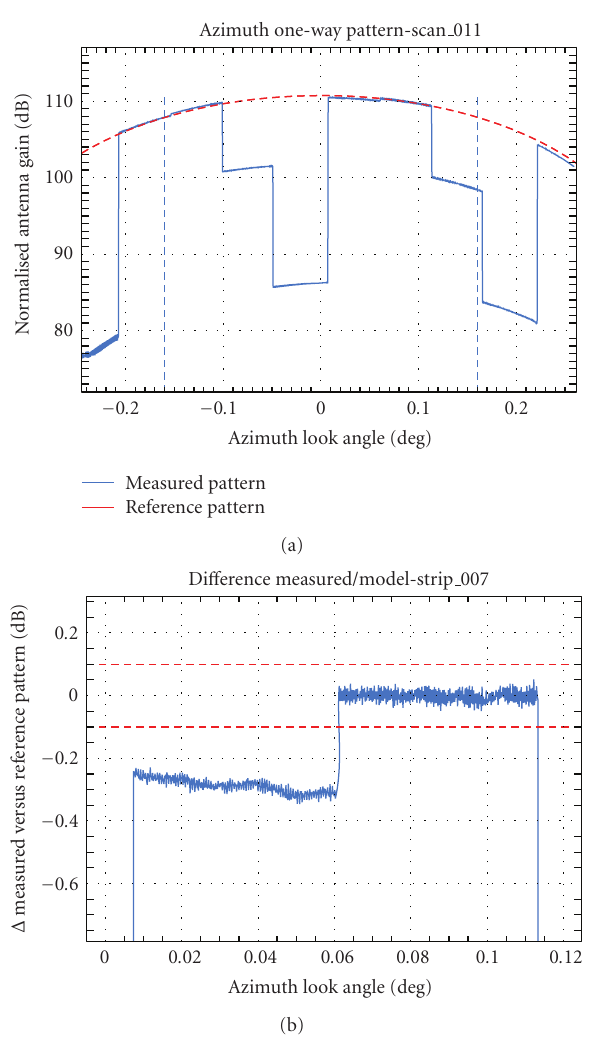
Figure 6: (a) Verification of the beam-to-beam-gain prediction using ground receivers. (b) Zoom into switching region between two